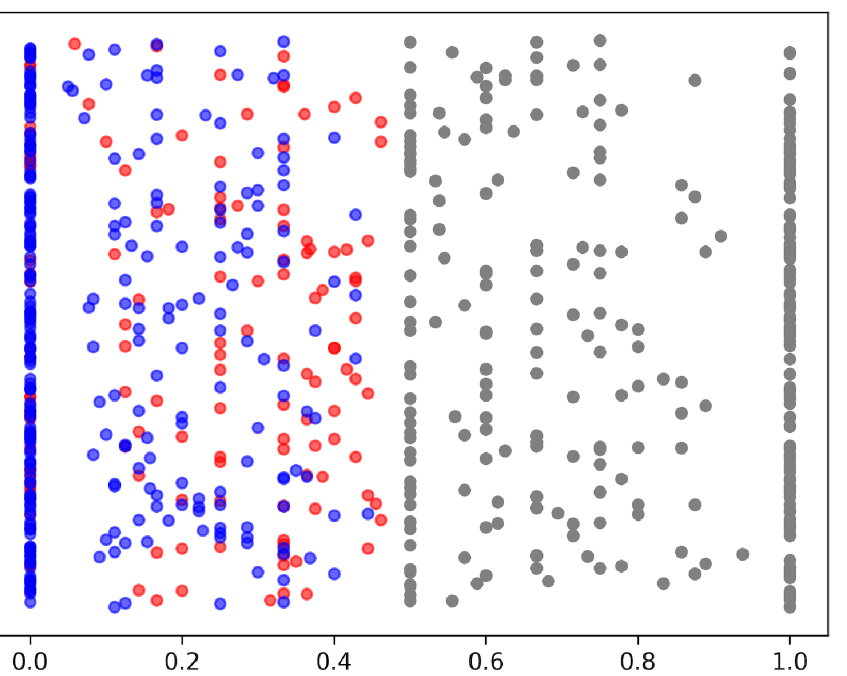
Fig 4. Origin rate of segments in discharge summaries against the inpatient records. Distribution of origin rates using bi-grams from the randomly sampled data. Red, blue, and gray dots are sourced, unsourced, and filtered out segments, respectively. Note that symbols and segments categorized as middle subjectivity are excluded. The y-axis values were randomly generated from a uniform distribution of visibility.